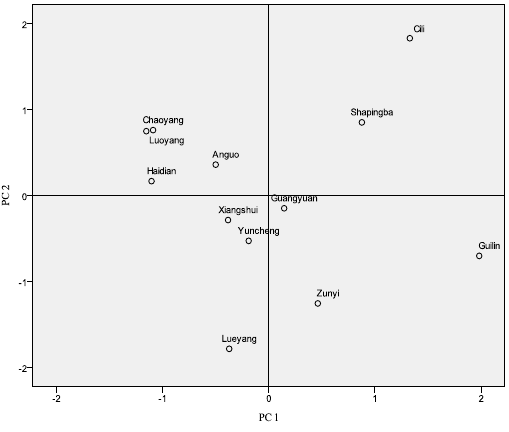
Figure 2. The relationship between different E. ulmoides populations based on PC1 and PC2.